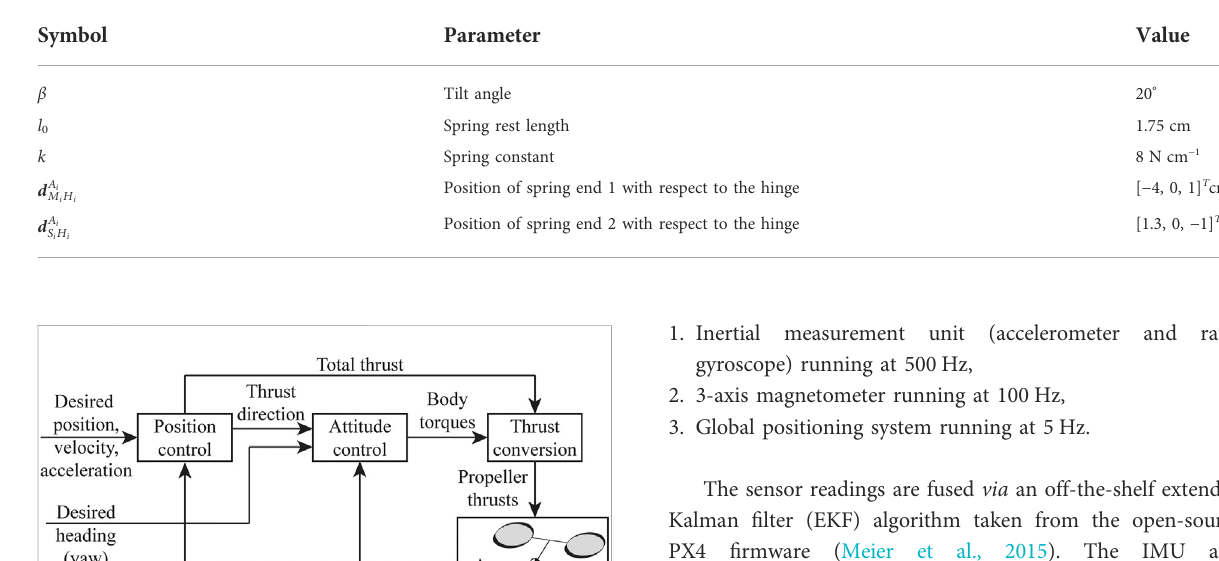
TABLE 2 Experimental vehicle tilting-related properties.